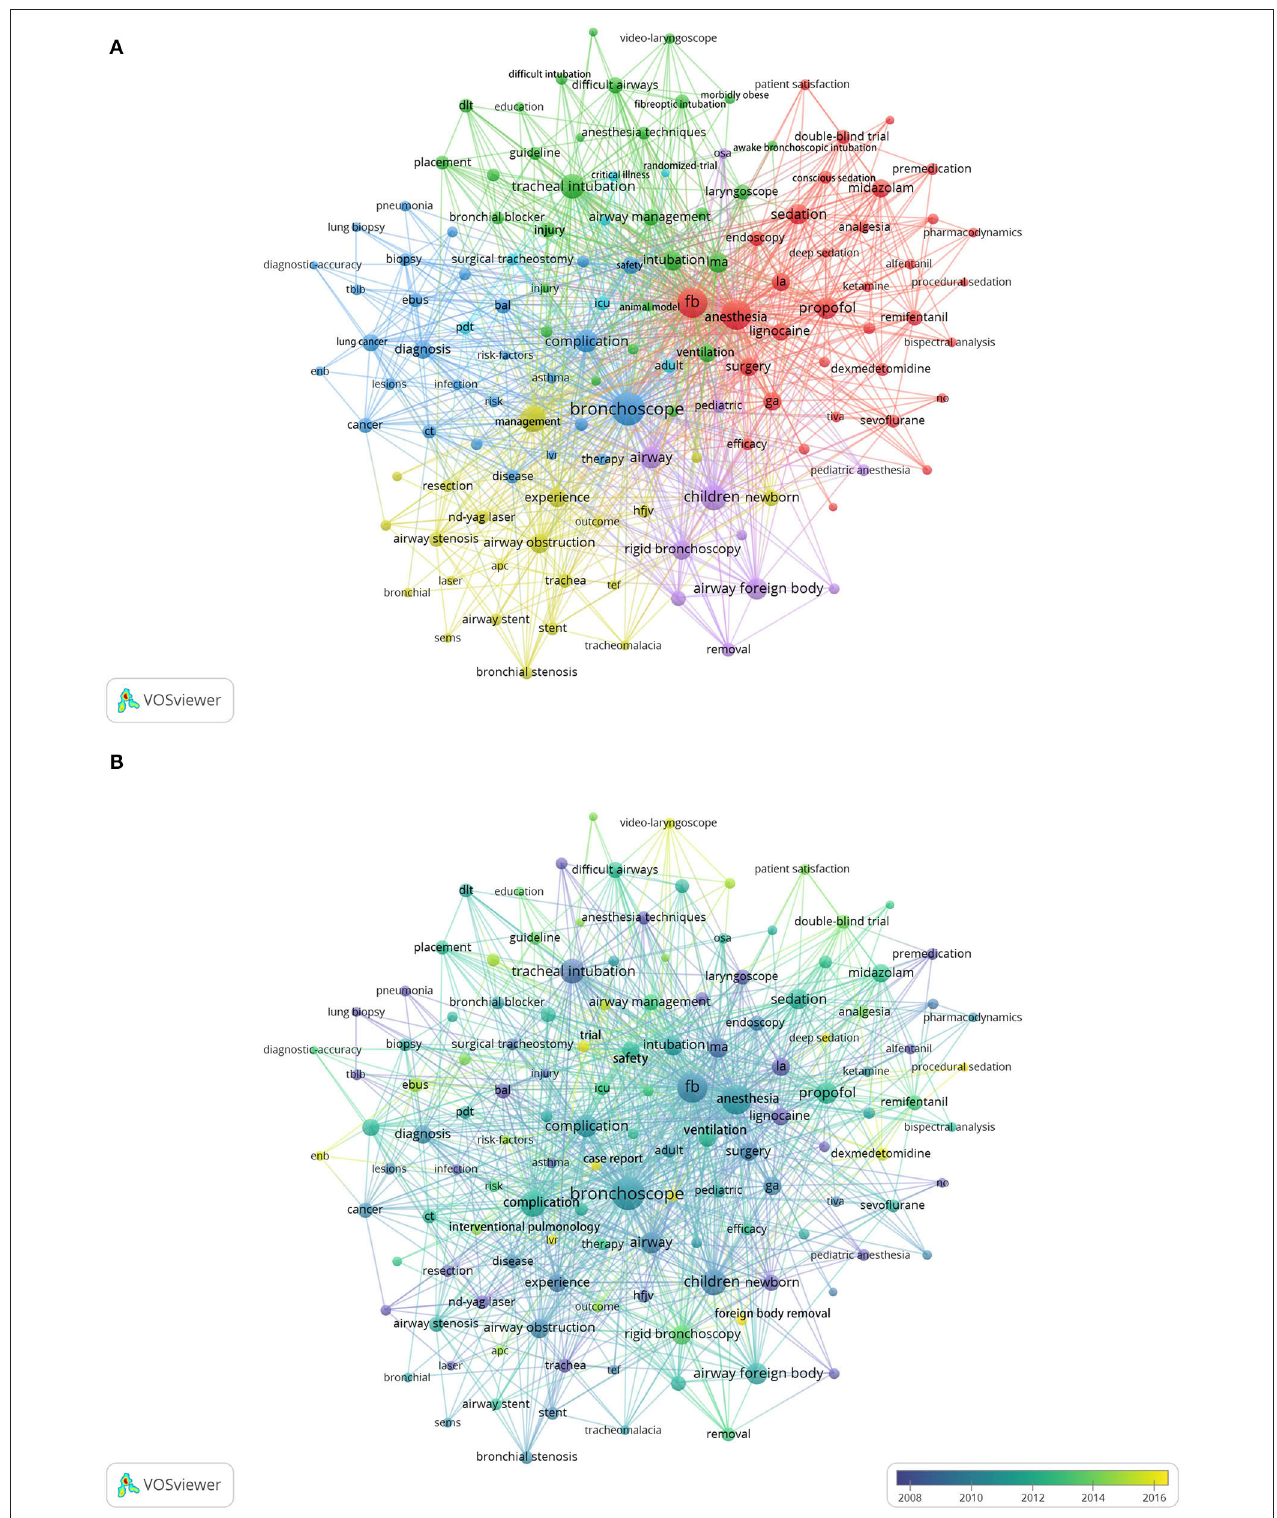
FIGURE 6 | (A) Analysis of keywords. (B) Visualization of time when a keyword appears.